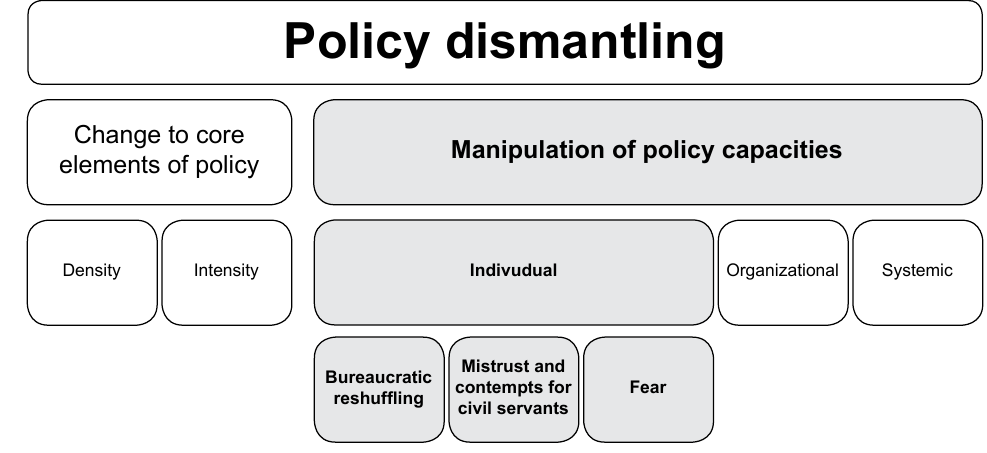
Based on Bauer & Knill (2012) and Wu, Ramesh, & Howlett